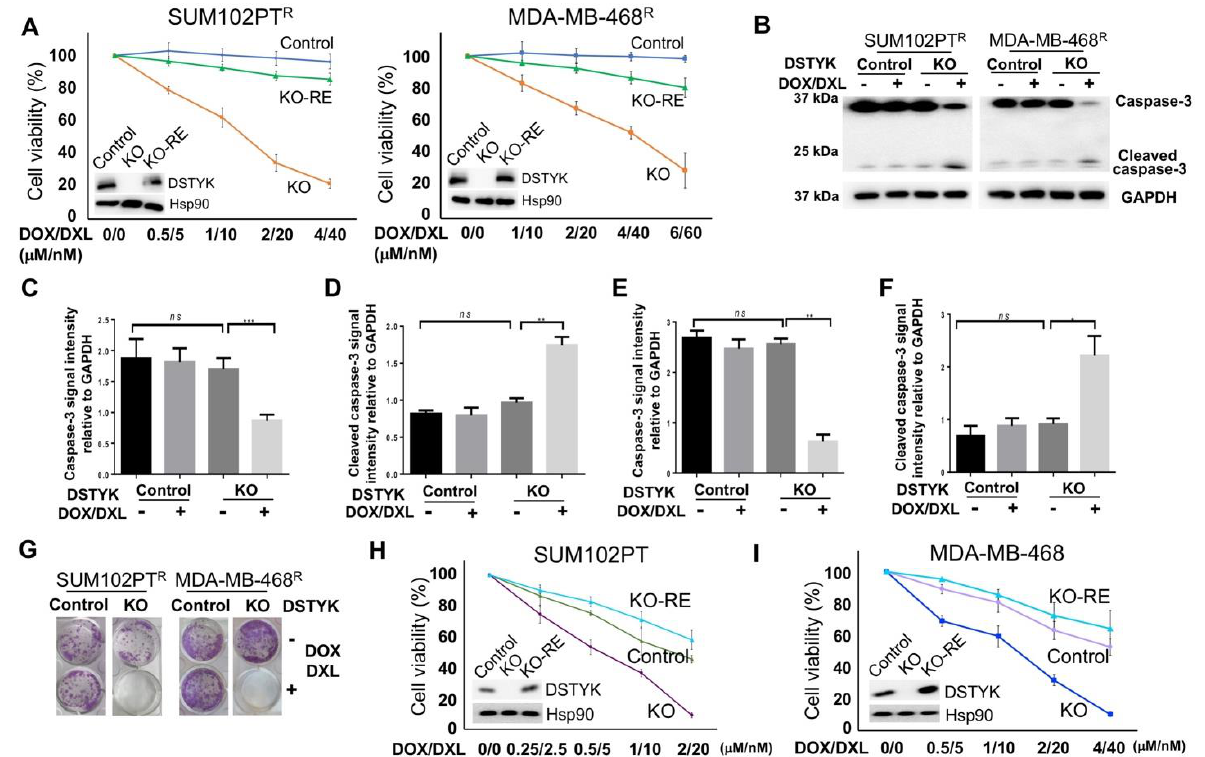
Figure 4. DSTYK is essential to the chemoresistance in TNBC cells. ( A ) MTT assays to compare the chemoresistance treated with different concentrations of DOX/DXL. The data presented represents the mean values ± SD ( n = 3). The levels of cellular DSTYK protein are indicated by the included WB. Hsp90 was used as the loading control. ( B ) WBs to detect the apoptosis marker cleaved-caspase 3 before and after DOX/DXL treatment (0.5/5 μM/nM for SUM102PT R cells; 1/10 μM/nM for MDA- MB-468 R cells). GAPDH was used as the loading control. ( C – F ) Quantification analyses of ( B ). ( G ) Clonogenic assays to confirm that chemoresistant cells regain chemosensitivity after DSTYK KO . DOX/DXL 4 μM/40 nm for SUM102PT R cells and 6 μM/60 nm for MDA-MB-468 R cells. ( H , I ) MTT